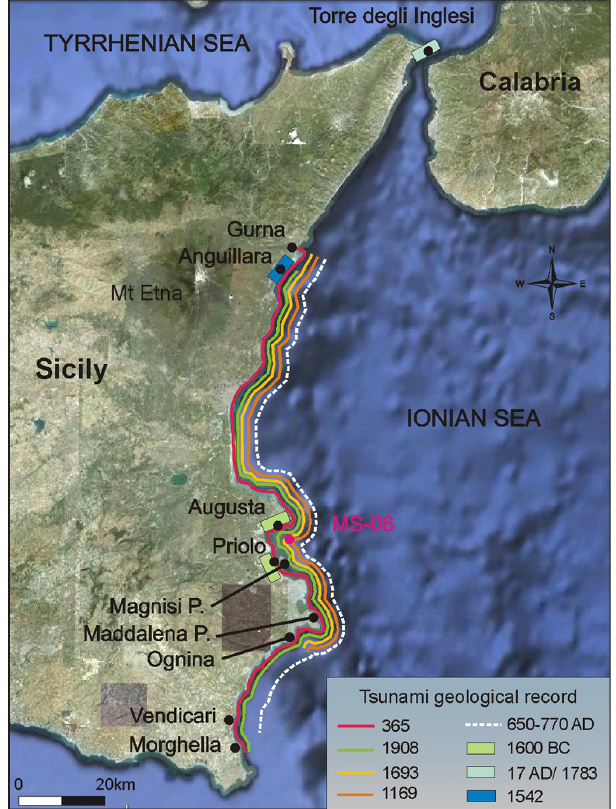
Fig. 7. Tsunamis geological record. Google Earth map of eastern Sicily synthesizing the portion of the coast hit by different tsunamis as coloured full lines, whereas the dashed line marks the coast in- undated by the largest unknown tsunami. Rectangles indicate the portions of coast inundated by local events (see legend for age cor- relation). Names of sites are the same as in Fig.